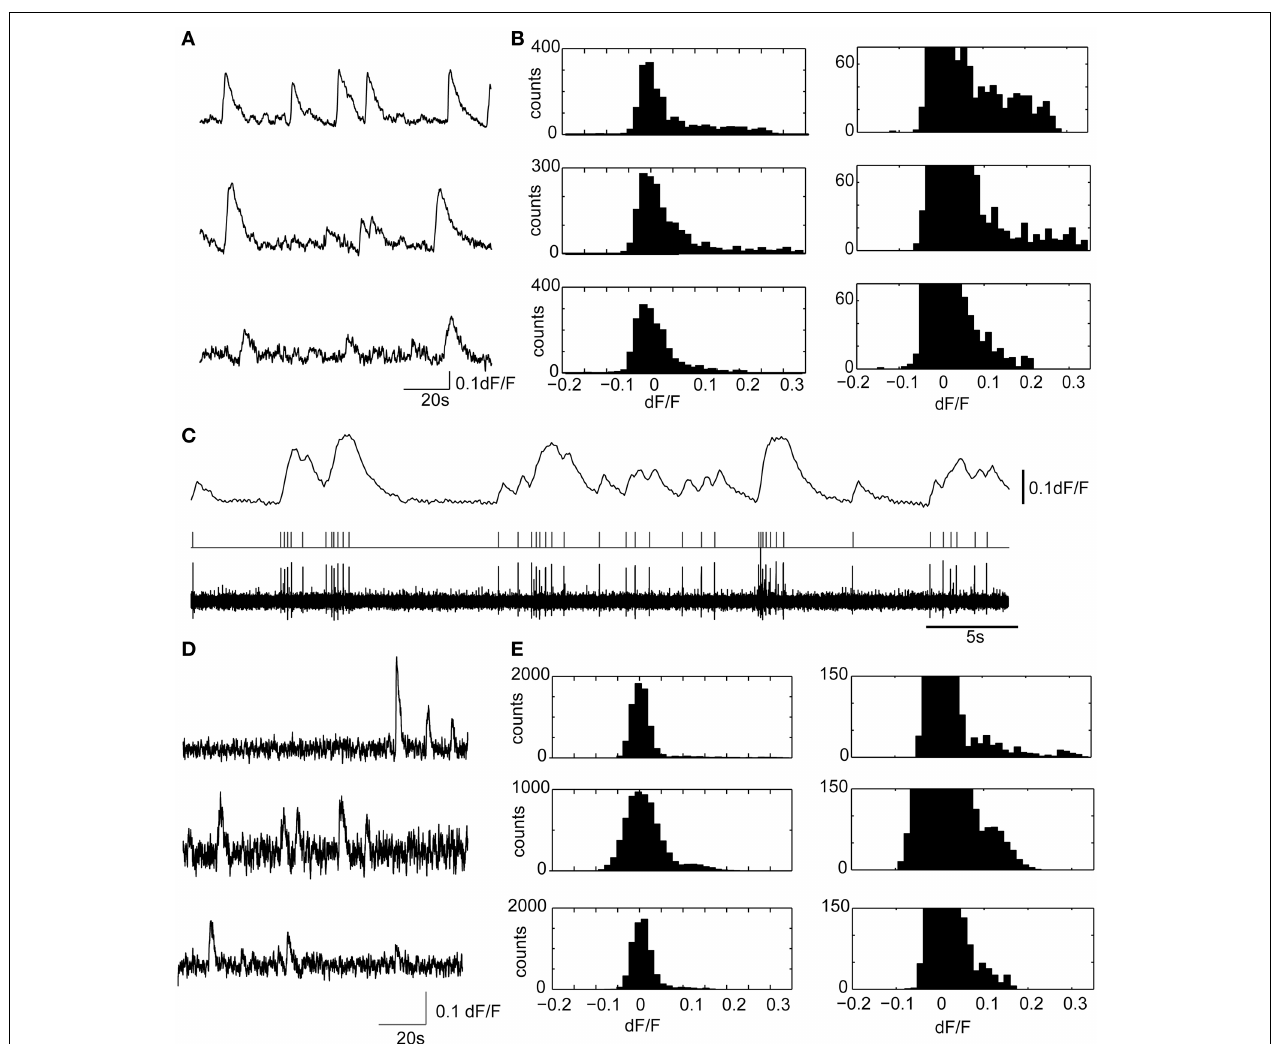
FIGURE 6 | Calcium transients in hippocampal slices display similar amplitudes and kinetics with confocal microscopy and volume projection 3D imaging. (A) Example calcium transients from three representative granule cell ROIs, acquired from the dentate gyrus, using a spinning disk confocal microscope. The sample preparation was identical to the brain slice experiments described in the main text. Only a short 2min segment of the data is shown. Data were acquired at 20 fps. (B) (Left) dF/F distributions for the three ROIs shown in (A) . On the right is the y-axis zoomed histogram, shown to highlight the positively skewed dF/F distributions characteristic of active neuron spiking. (C) A representative experiment showing the ability of Fura-2AM calcium transients to faithfully resolve action potential firing in a cell attached recording. The deconvolved calcium dynamics (above) from a cell